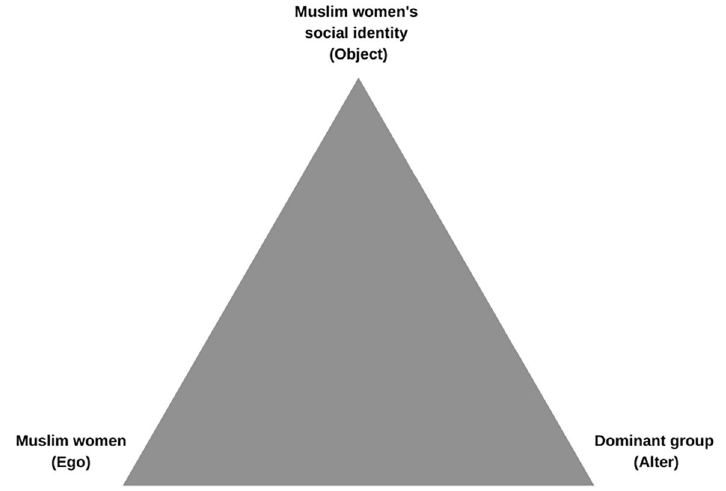
Misrecognition as an Interactional